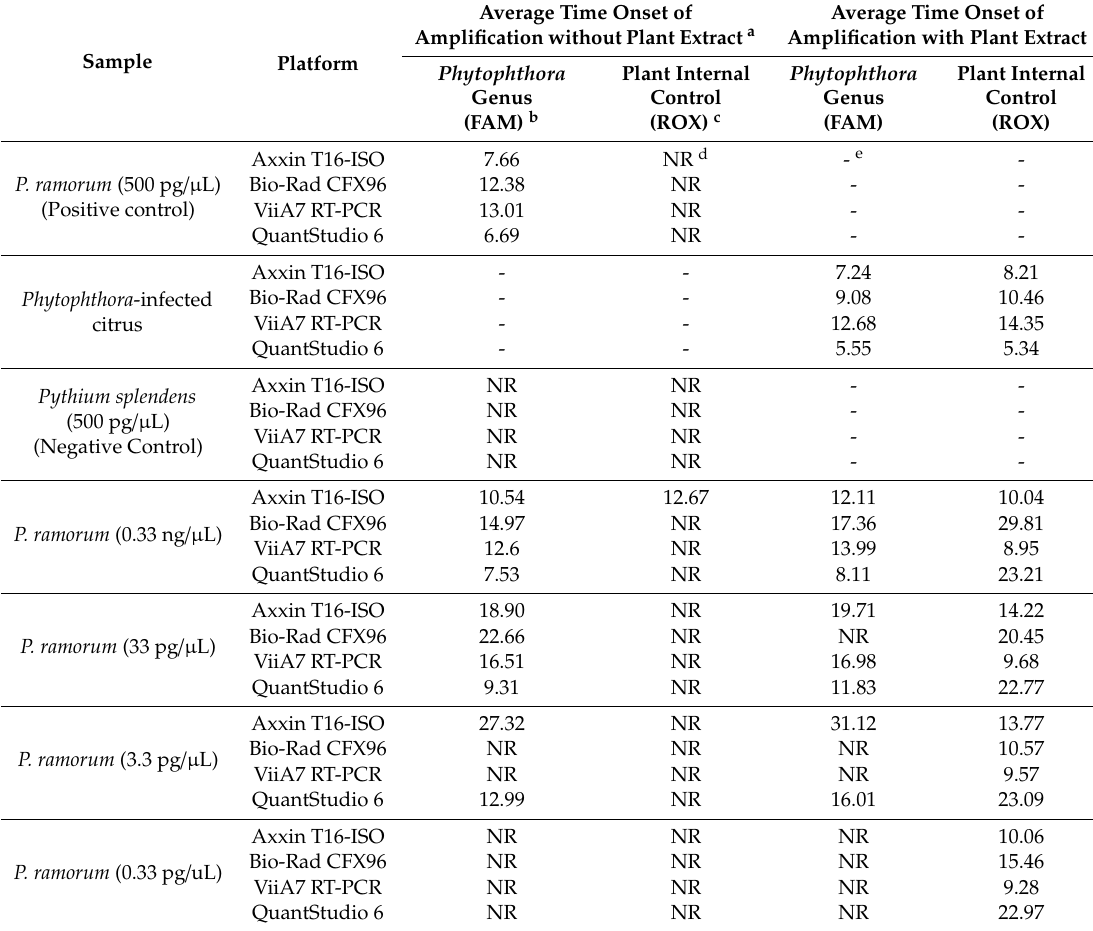
Table 2. Initial validation of preformulated lyophilized RPA assay on crude plant extracts and purified Phytophthora ramorum or Pythium splendens